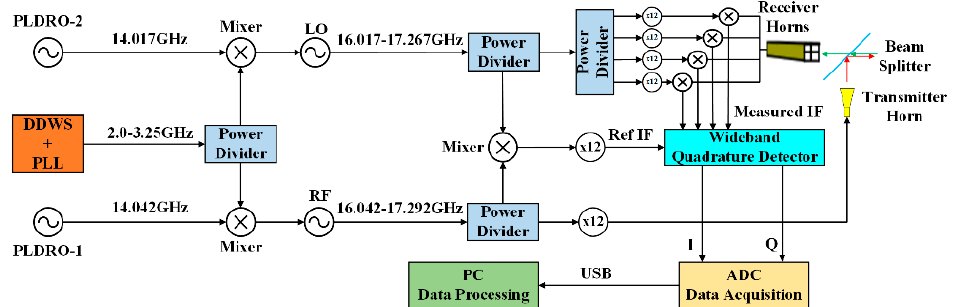
Figure 1. Block diagram of the single input and multi-output (SIMO) system.